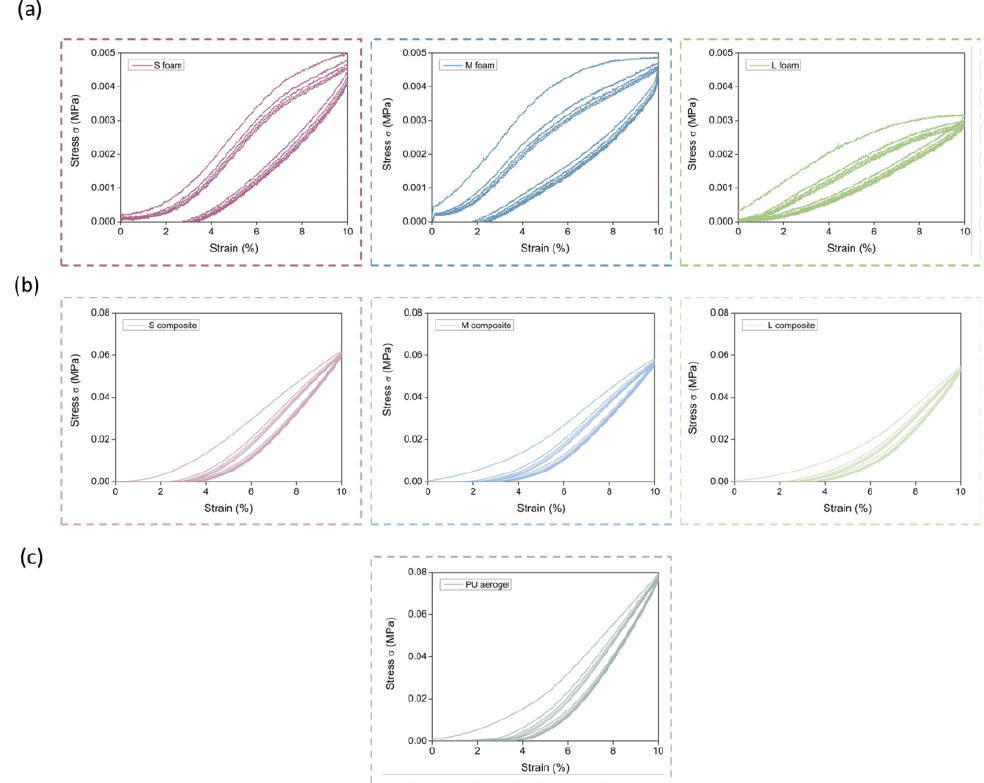
Figure 5. Compression – decompression curves for ( a ) polyurethane foams, ( b ) PU F – PU A composites, ( c ) polyurethane aerogel at a strain of 10%.